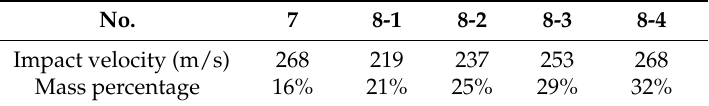
Table 2. Mass percentage of the particles with the sizes less than 0.3